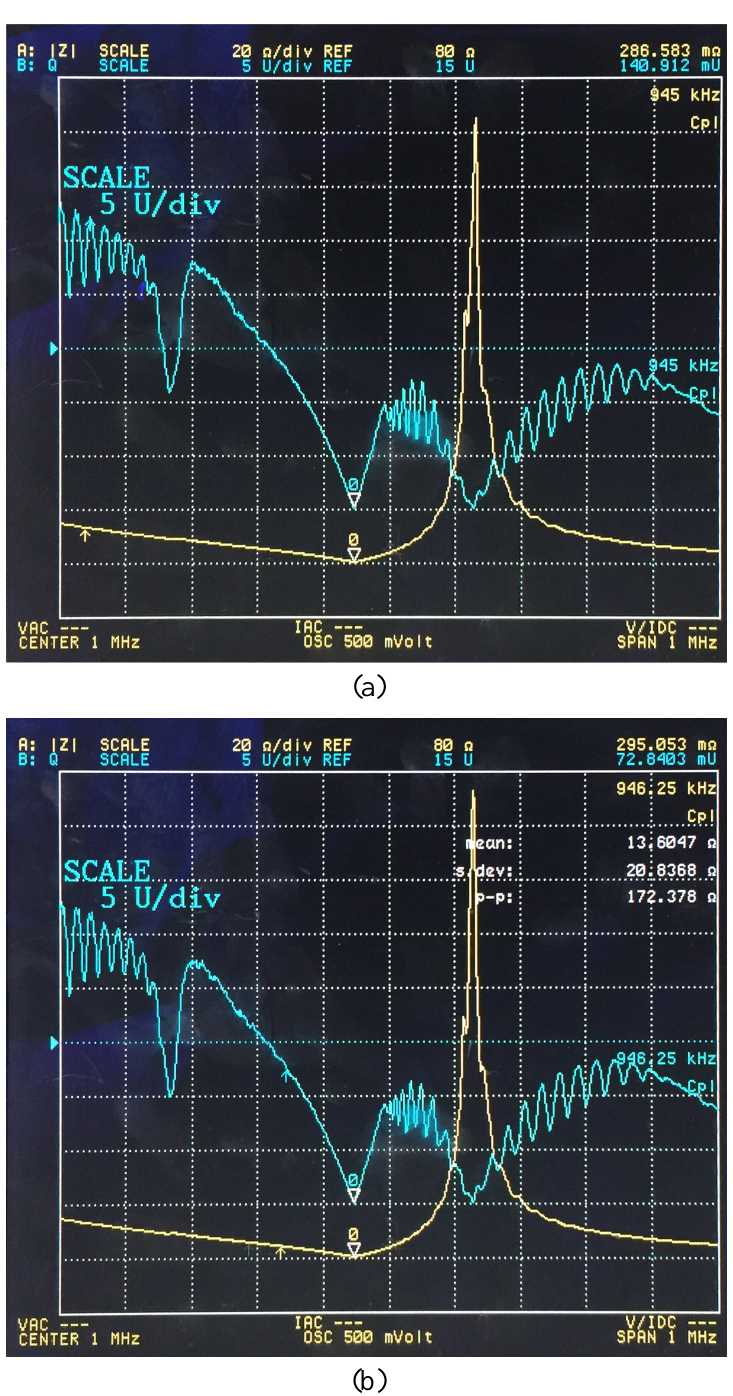
Figure 2. Impedance and quality factor measurement results of the transducers (frequency range: 0.5–1.5 MHz): ( a ) Impedance modulus (yellow) and quality factor (cyan) of the TX (transmitter) transducer; ( b ) Impedance modulus (yellow) and quality factor (cyan) of the RX (receiver)